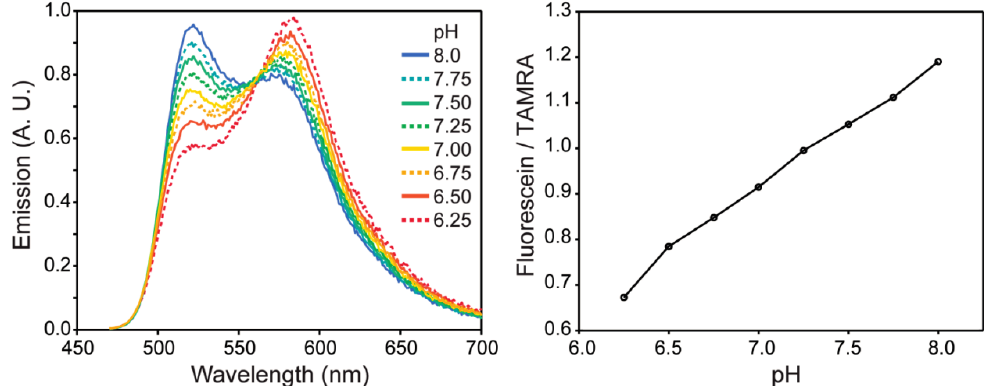
Figure 11. Coupling fluorescein and TAMRA dyes to the surfaces of Fe 2 O 3 nanoparticles creates a FRET pair between the two chromophores to produce a ratiometric emission spectrum as a function of